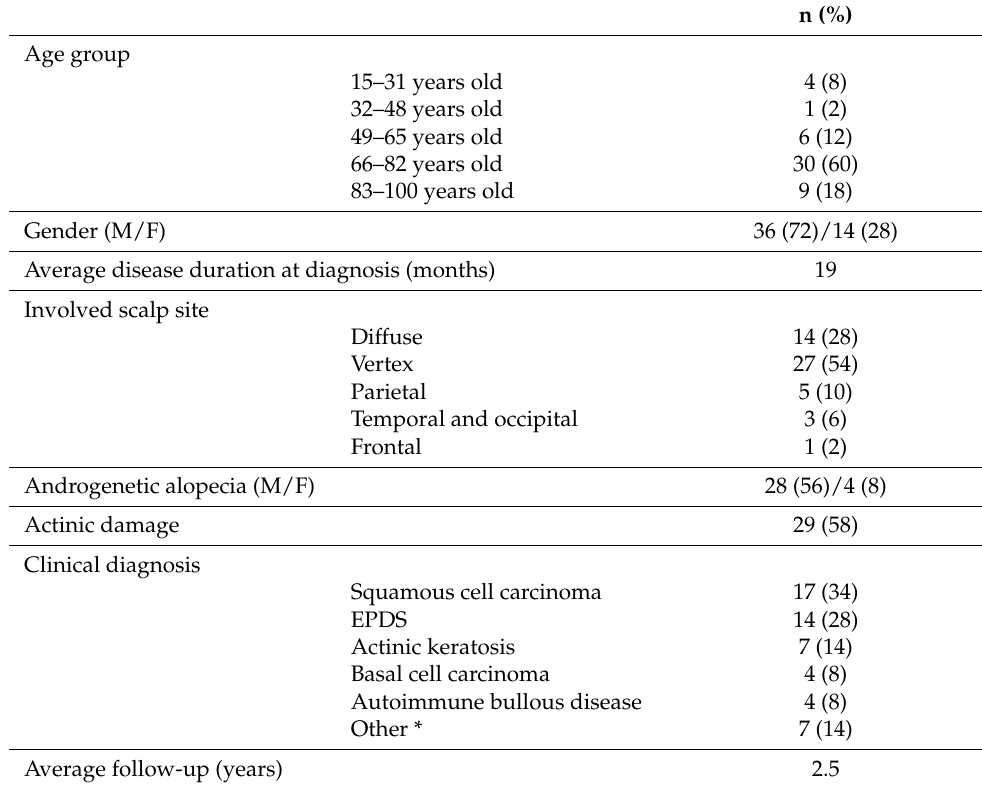
Table 2. Clinical data summary.